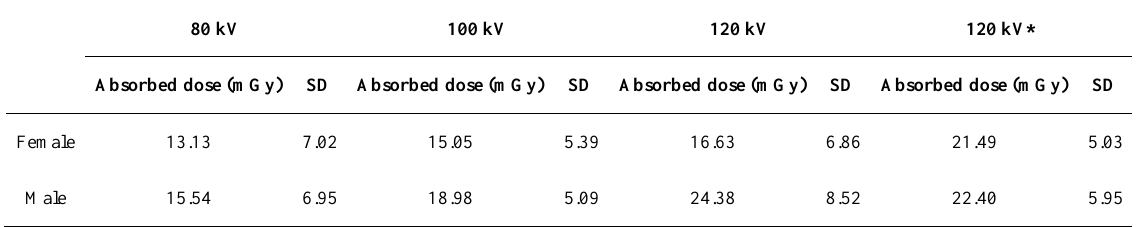
Table 2. Average absorbed dose in mGy for anthropomorphic female and male phantoms 80 kV 100